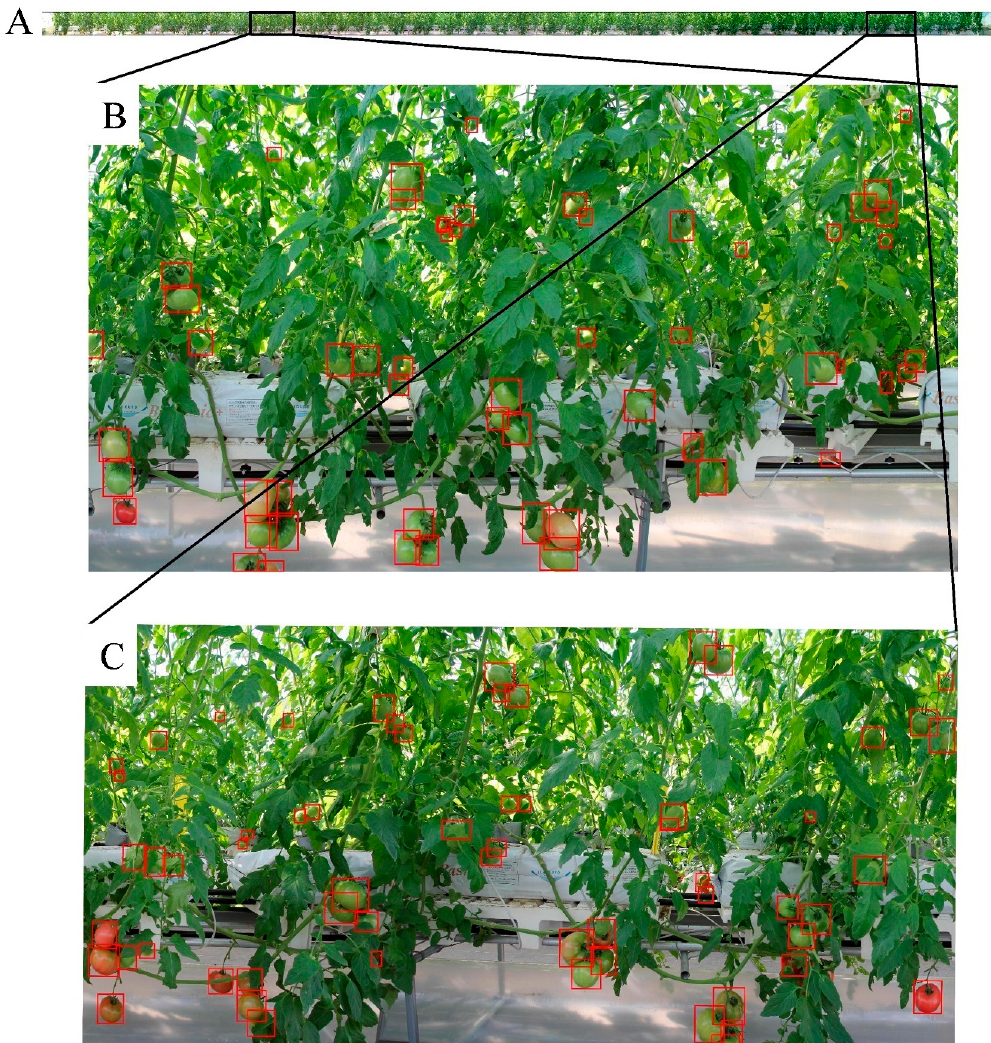
Figure 8. Detected bounding boxes of the tomatoes in the stitched image. ( A ) is the location map for tomatoes in one row; ( B ) and ( C ) are two enlarged zones in ( A ) for clear illustration. tomatoes in one row; ( B , C ) are two enlarged zones in ( A ) for clear